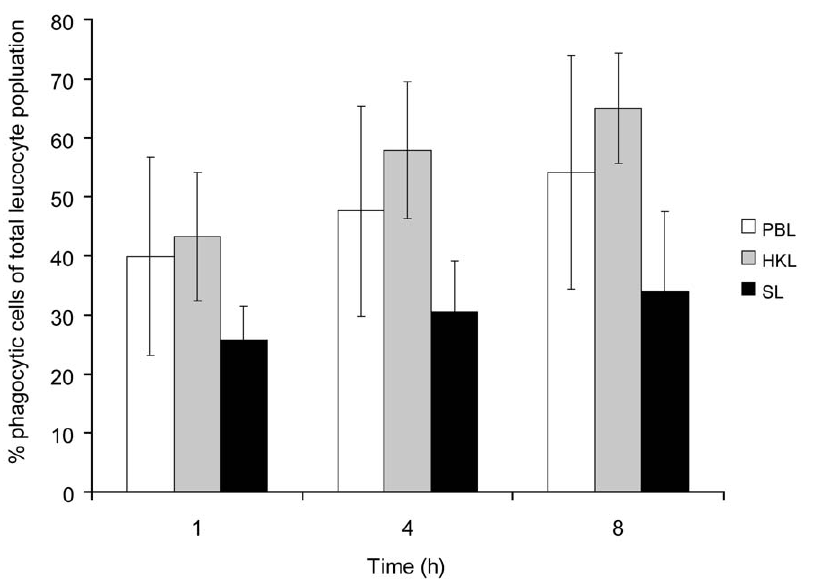
Figure 4. Isolated leucocytes have potent phagocytic ability. Proportions of phagocytic leucocytes of total PBL, HKL and SL after 1, 4 and 8 hours ingestion of fluorescent beads measured by flow cytometry (mean, bars indicate SD, N=6).